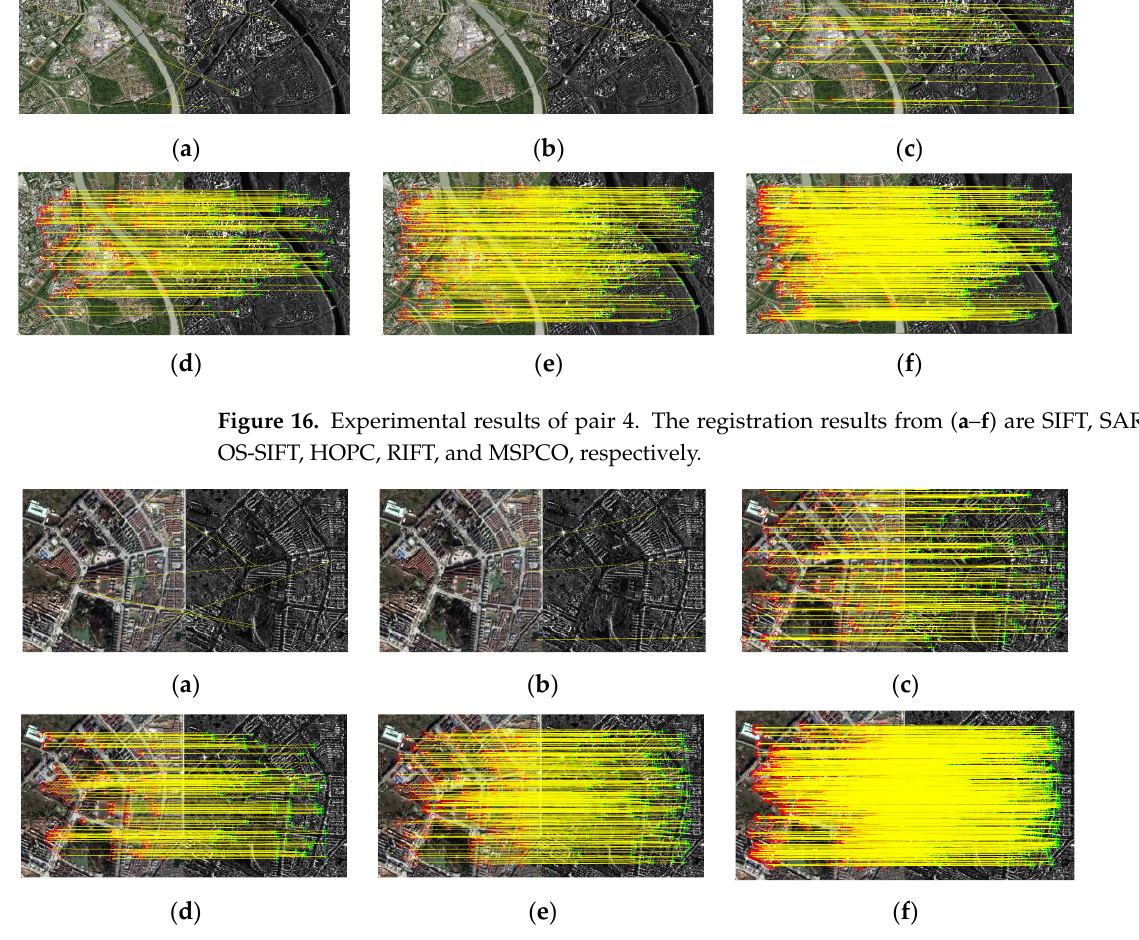
Figure 17. Experimental results of pair 5. The registration results from ( a ) to ( f ) are SIFT, SAR-SIFT, OS-SIFT, HOPC, RIFT, and MSPCO, respectively.